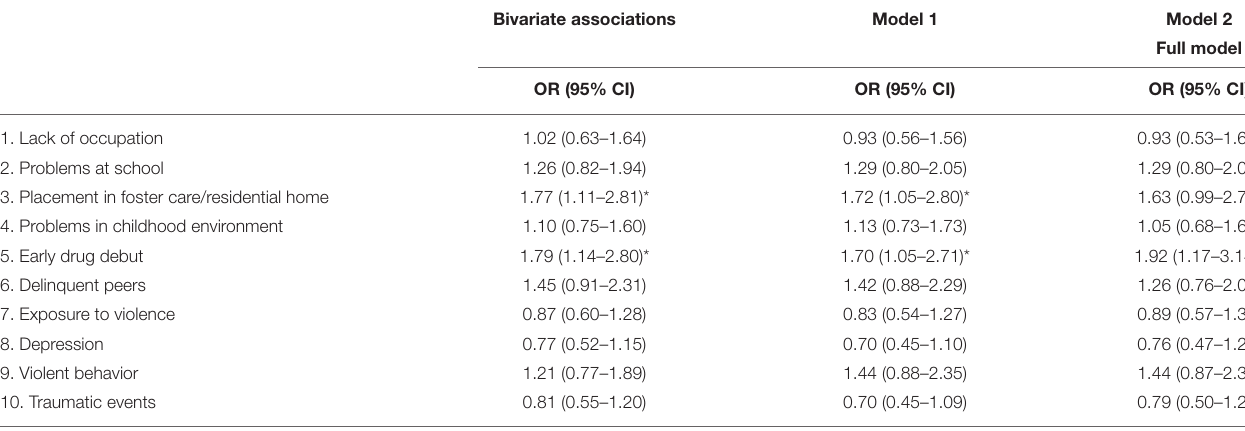
TABLE 2 | Bivariate associations and logistic regression analyses of risk factors regarding indications of SUP 3 years after initiation of treatment.